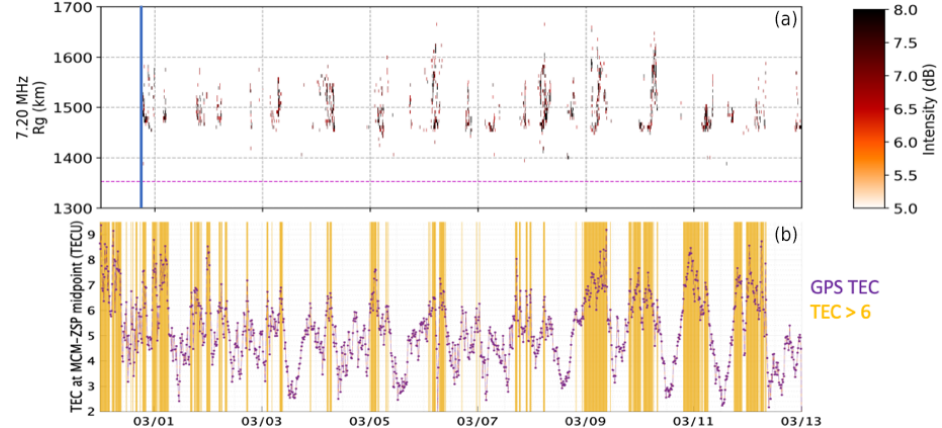
Figure 5. Panel (a) shows 7.2MHz echoes from the McMurdo–South Pole demonstration and (b) MIDAS GPS TEC at the midpoint between McMurdo and the South Pole. TEC values > 6TECU are highlighted to illustrate the correspondence between TEC enhancements and sporadic F-region propagation. The time when the transmitter was switched on is shown in blue in (a)